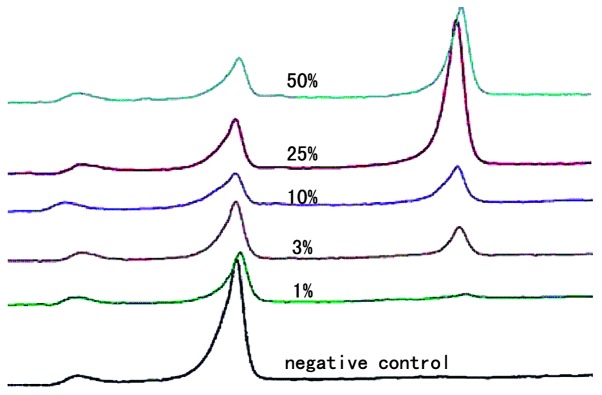
Results of multiplex allele-specific PCR detection of BRAF V600E mutation sensitivity. 1–50%, different concentrations of the positive control; negative control, RO82-W-1 cells.